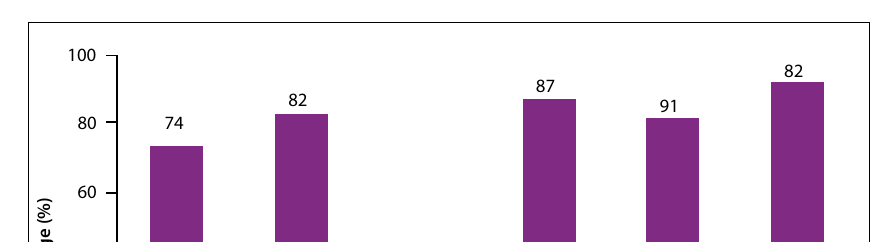
Fig. 2. Exposure to psychiatric